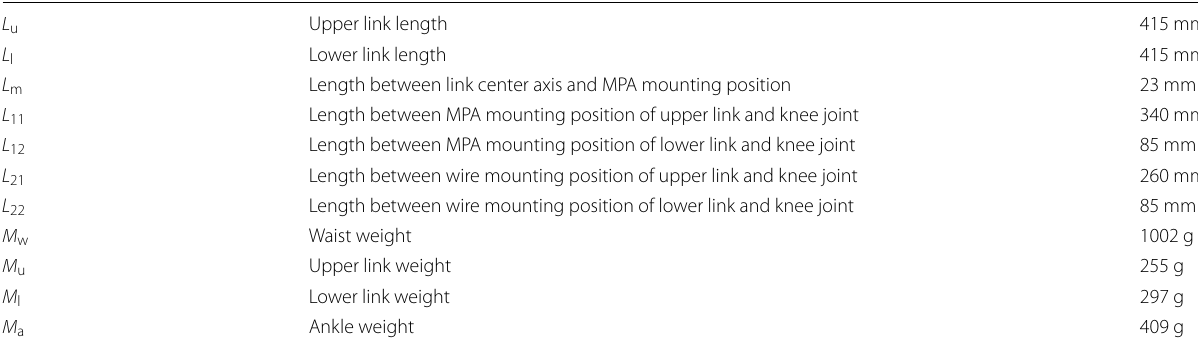
Table 1 Numerical value of each parameter of the robot L u Upper link